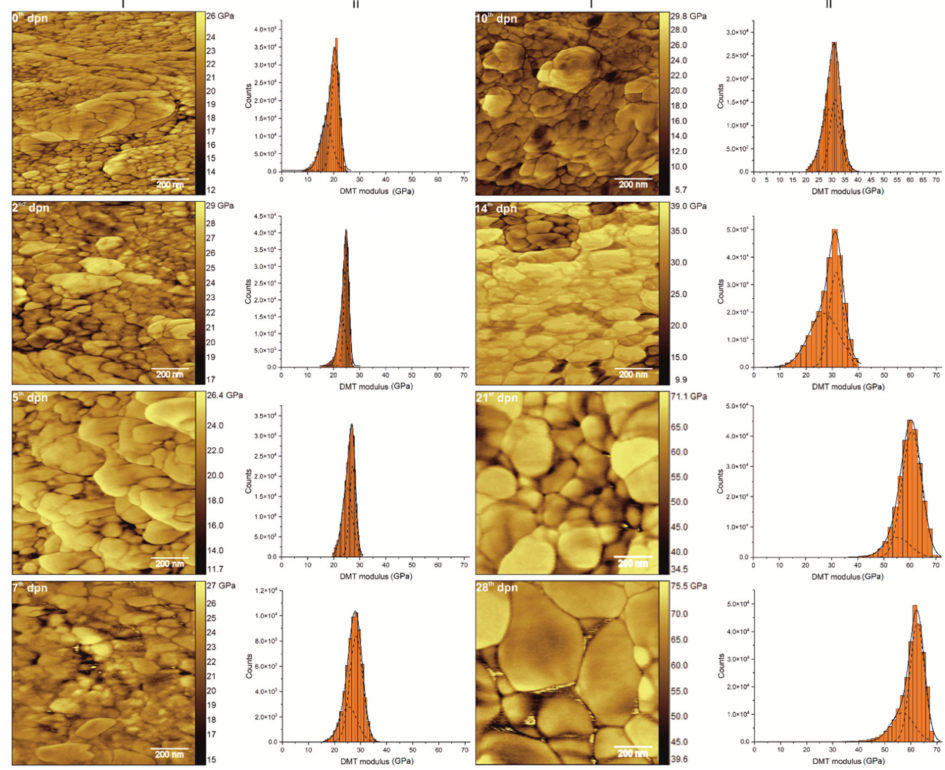
Figure 9. Peak Force QNM representative scans (1 µ m × 1 µ m) of enamel surface (I) with correspond- ing histograms of averaged DMT modulus distribution (II) determined for 0th, 2nd, 5th, 7th, 10th, 14th, 21st and 28th day of postnatal life (dpn) with Gaussian functions fitted. Scale bars are equal to 200